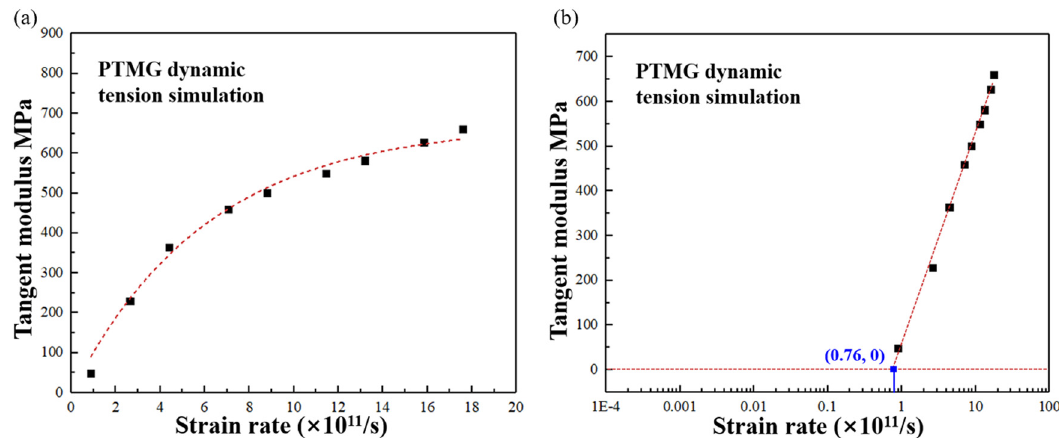
Figure 3: Relation between strain rate and tangent modulus of the PTMG material model: ( a ) positive strain rate dependency of tangent modulus and ( b ) critical strain rate to induce the transition of mechanical behavior of a material from rubber - like behavior at low strain rate to glass - like behavior at high strain rate.